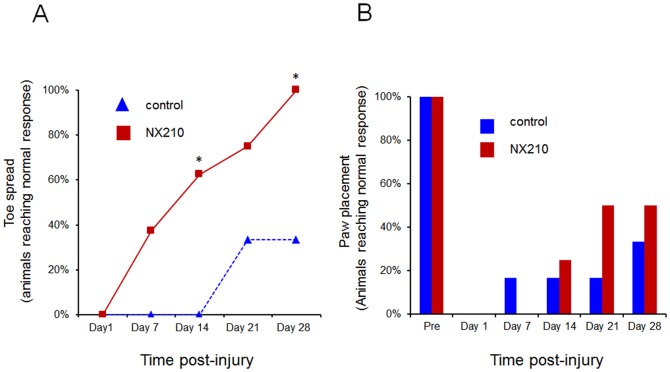
Effects of NX210 on functional recovery after SCI: reflex testing.Data are expressed as the percentage of animals providing a normal response to the tests (A) Toe spread. (B) Paw placement. Compared to pre-injury values, NX210-treated rats (n = 8) and vehicle-treated rats (n = 8) showed a significant impairment in both tests the day following the injury. However, at D21 and D28 post-injury, the NX210-treated group showed a significant improvement. Considering toe spread reflex, animals of the vehicle group reach a plateau at D21 whereas in the NX210 treated group, all the animals recover at the end of the study. Data are presented as group mean ± SEM. * significantly different from vehicle group, p<0.05.